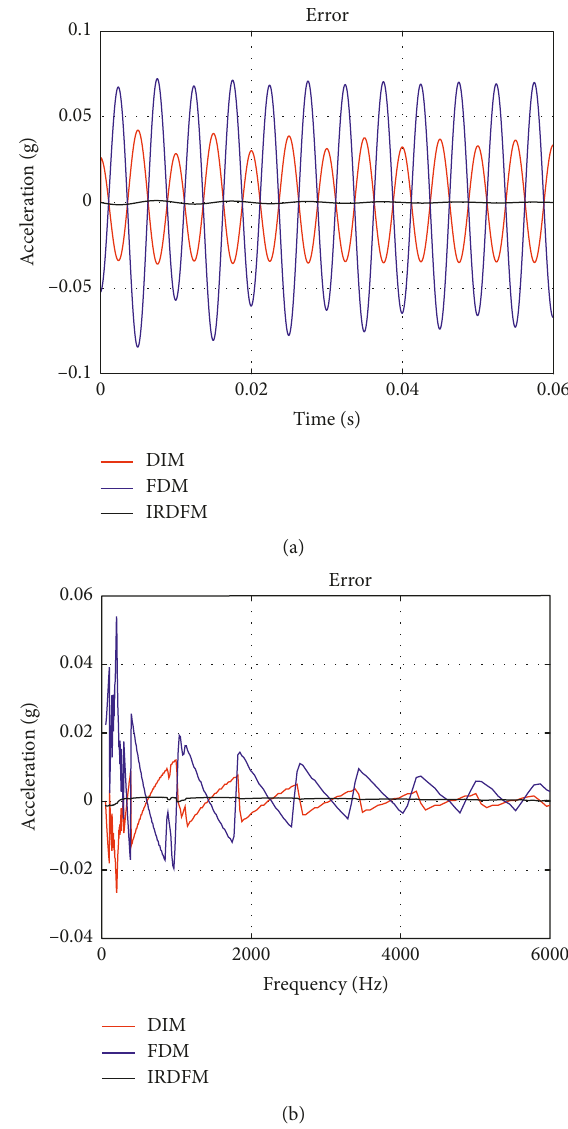
Figure 4: Three numerical calculation methods to calculate the error of impact